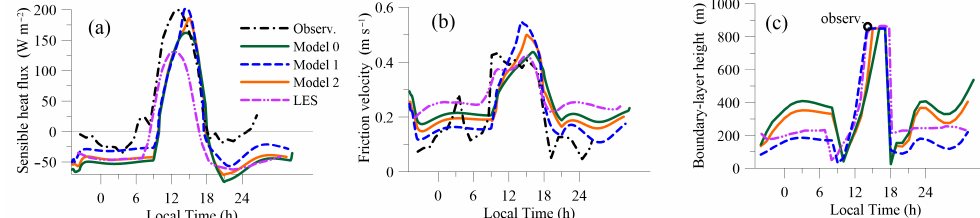
Figure 6. Comparison of single-column results with observations data from [14]. ( a ) Sensible heat flux evolution. ( b ) Friction velocity evolution. ( c ) Boundary-layer height evolution. LES data taken from